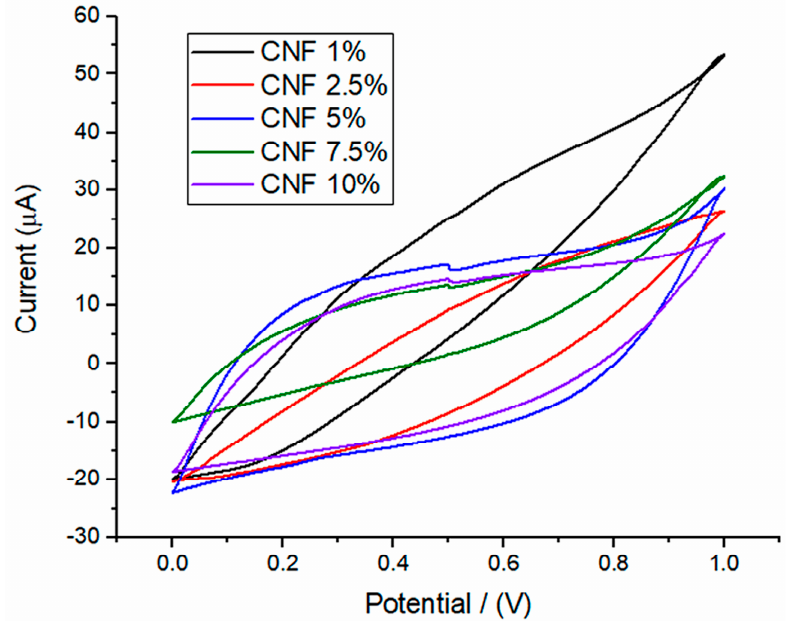
Figure 4. Cyclic voltammogram of a carbon electrode and carbon electrodes modified with CNF-Fe (C/CNF-Fe) at different iron percentages 1%, 2.5%, 5%, 7.5% and 10%, using a pH 4.2 buffer solution.